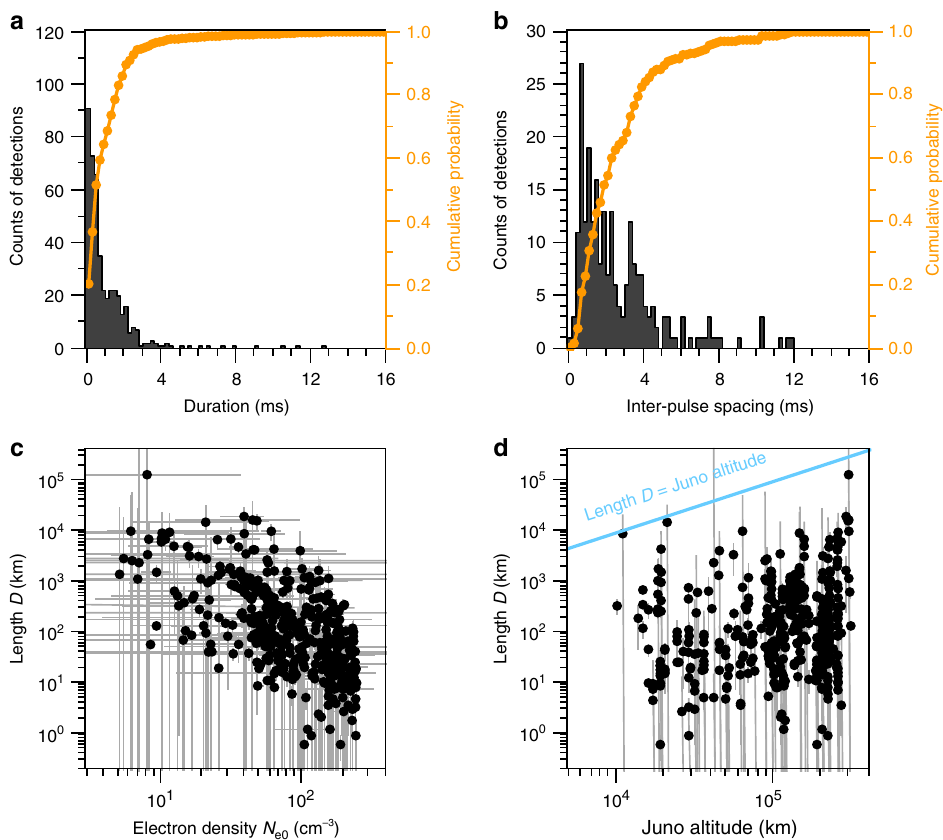
Fig. 2 JDP properties based on Juno ’ s observations and the propagation model. Distributions of JDP detections are organised as a function of a duration and b inter-pulse spacing using the left-hand axes. Each bin of both histograms is 0.2 ms. Using the right-hand axes, the orange lines are displayed for the corresponding cumulative probability. Note that the maximum of 16 ms for both duration and inter-pulse spacing is due to the length of the Waves LFR-Hi waveform snapshot. Density irregularities are modelled by a step function with height N e0 and length D using the O mode straight-line propagation model. The estimates of length D are plotted as a function of c N e0 and d Juno altitude using logarithmic scales. The grey error bar corresponds to one standard deviation (68% con fi dence interval) of N e0 and D . The median values of the one standard deviation from the model fi ttings are 27.5%± 2.5% for D and 2.5% ± 2.5% for N e0 (Supplementary Fig. 9)